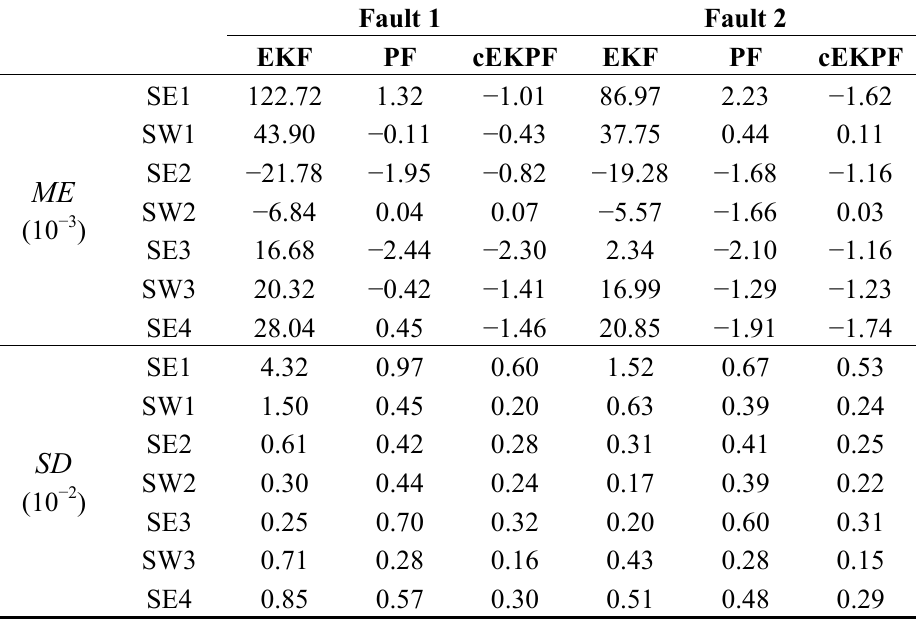
Table 5. Mean error and standard deviation of the estimation with non-Gaussian